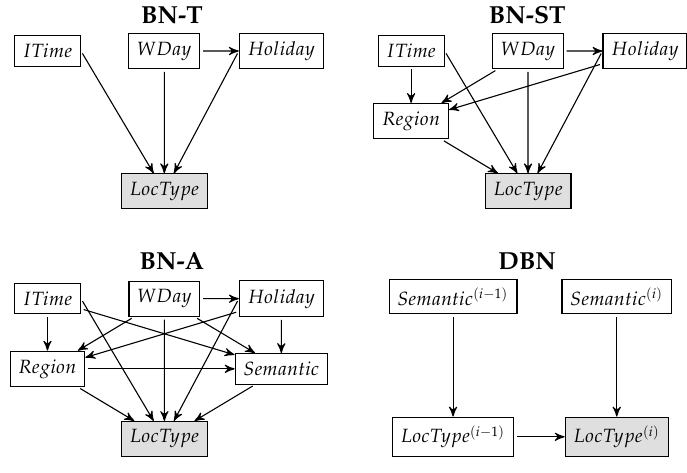
Figure 2. Bayesian models for experimentation.